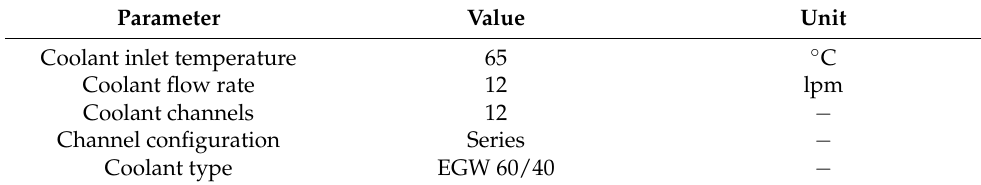
Table 10. 36/24 SRM thermal model